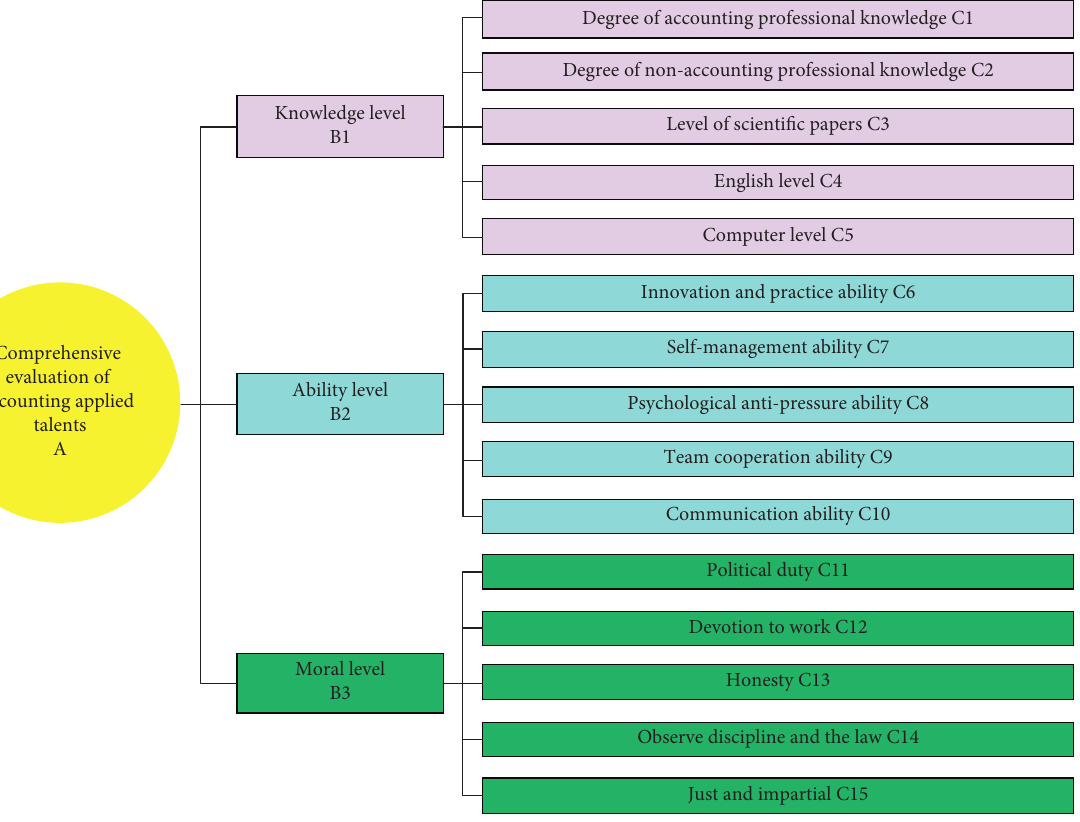
Figure 1: Evaluation index system of comprehensive ability of accounting applied talents. Table 1: Mapping between comment set and fuzzy